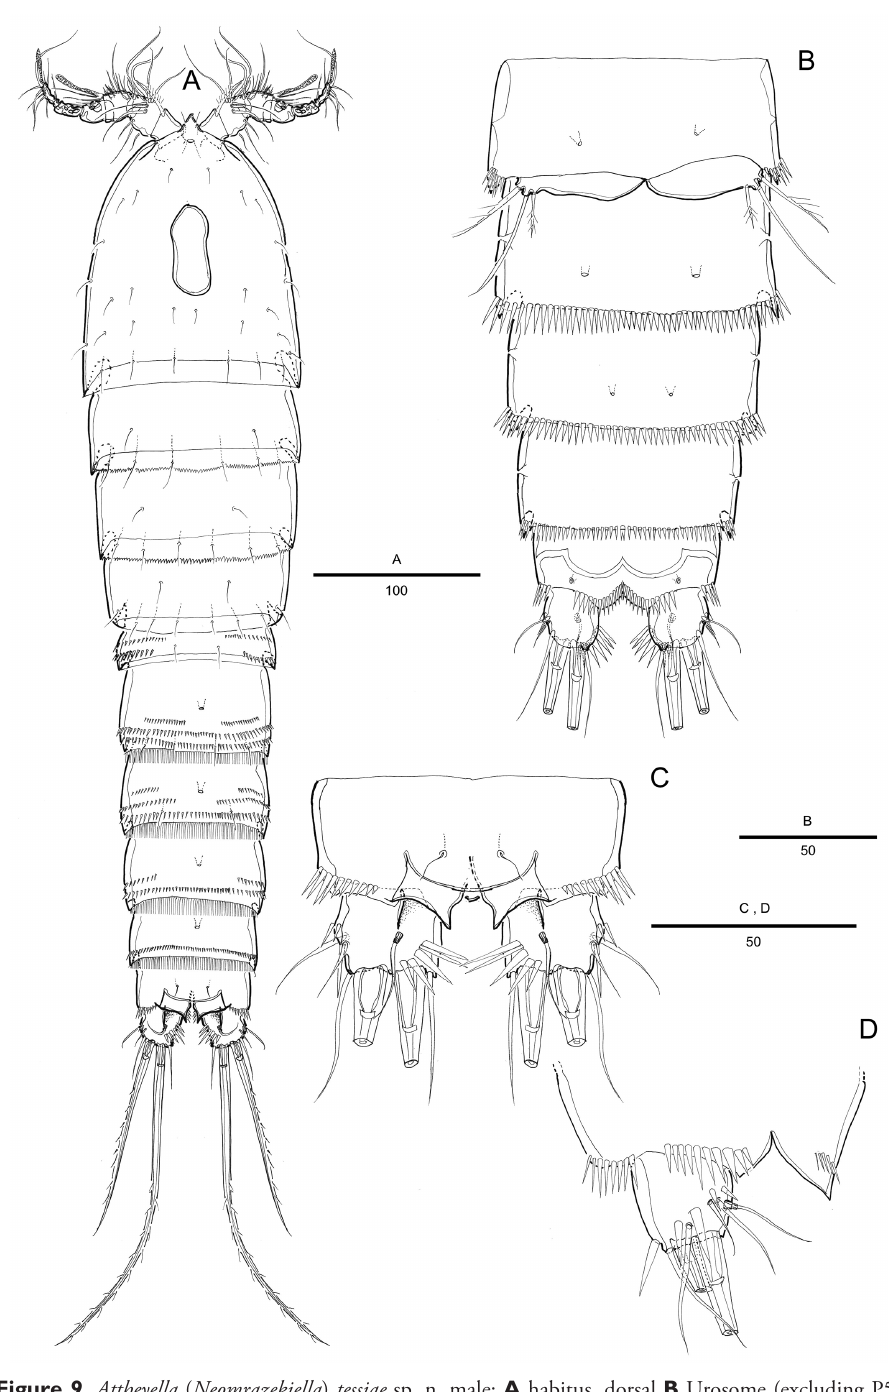
Figure 9. Attheyella ( Neomrazekiella ) tessiae sp. n. male: A habitus, dorsal B Urosome (excluding P5- bearing somite), ventral C anal somite and caudal rami, dorsal; E anal somite and caudal ramus,